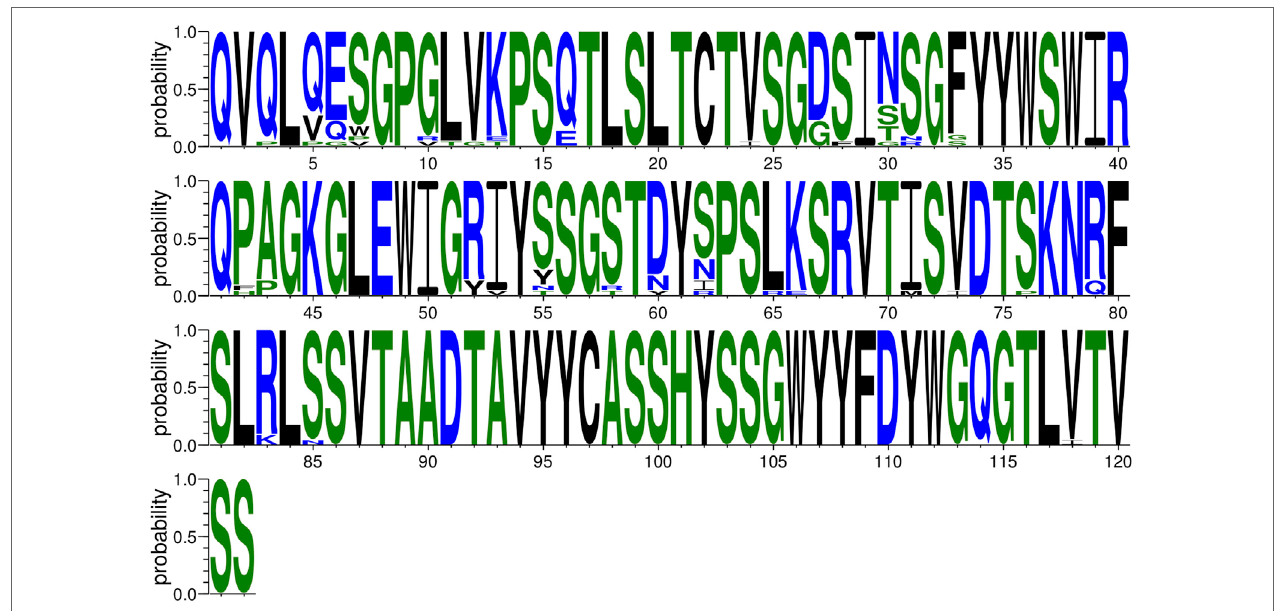
FIguRe 9 | Sequence logo of one of the top